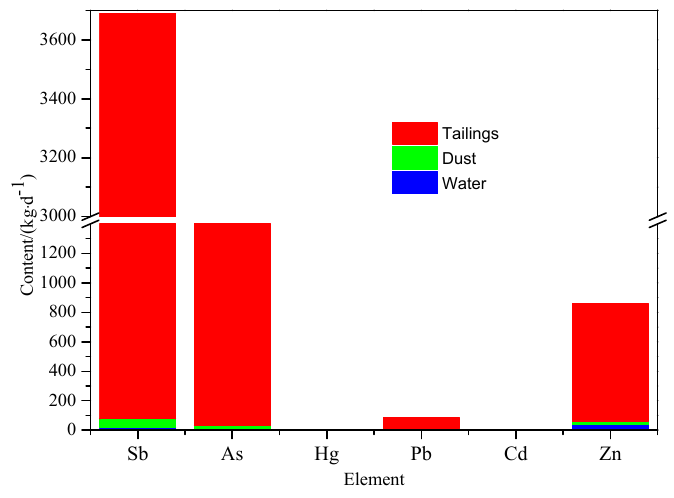
Figure 5. Individual PTEs contents in different waste streams.